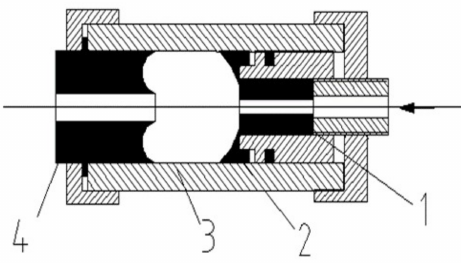
Figure 1. Schematic diagram of a self-oscillatory pulse gas–liquid jetting nozzle: (1) upstream nozzle; (2) upstream impinging wall; (3) oscillation chamber; (4) downstream nozzle.